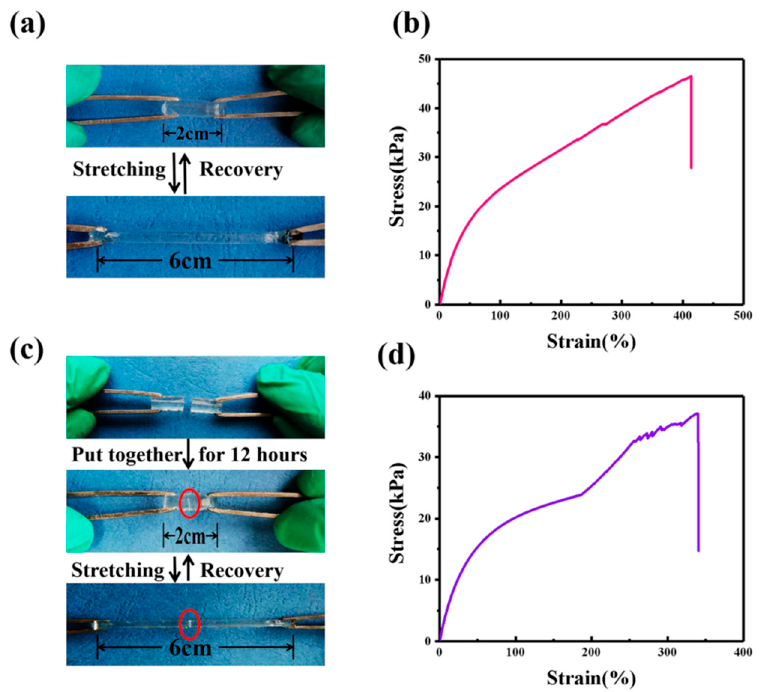
Figure 7. ( a ) Photographs demonstrating stretching of GPE-ILs. ( b ) Tensile stress strain of GPE-ILs. ( c ) Photographs demonstrating self-healing and stretching of GPE-ILs. ( d ) Tensile stress strain of self-healing GPE-ILs.